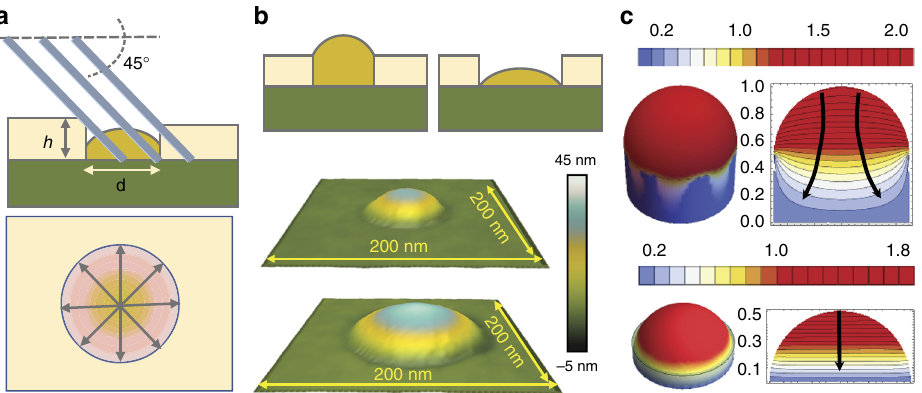
Fig. 4 The diffusion model explaining the role of the hole aspect ratio d / h in improving the yield. a Top: schematics of the droplet con fi guration within the opening with respect to the impinging arsenic fl ux; bottom: schematics of the arsenic gradient created due to the sidewall shadowing. b AFM measurements of gallium droplets for 10 min pre-deposition time at an oxide thickness of 10 nm, showing the modi fi cation of the droplet shape from full wetting, through partial wetting of the mask walls and ultimately non-wetting of the mask walls for largest d / h ratio; top sketches showing the two wetting con fi gurations in the cross-section c 3D representations and 3D cuts of the calculated arsenic concentration pro fi les for the two wetting con fi gurations corresponding to different d / h (top: d / h = 2, bottom: d / h = 6). The values in the color scale correspond to the arsenic